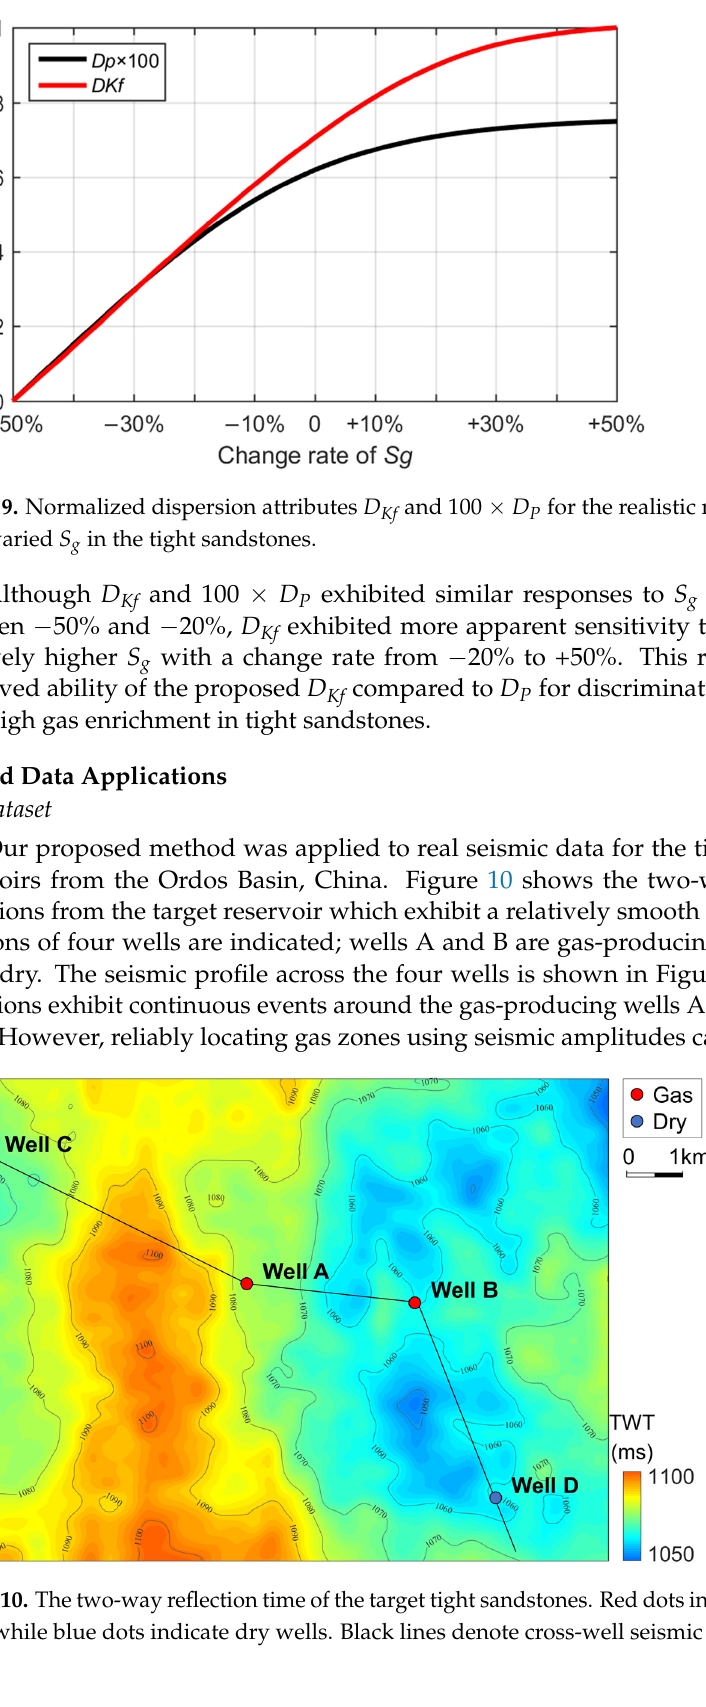
Figure 10. The two ‐ way reflection time of the target tight sandstones. Red dots indicate gas ‐ produc ‐ ing wells, while blue dots indicate dry wells. Black lines denote cross ‐ well seismic lines.